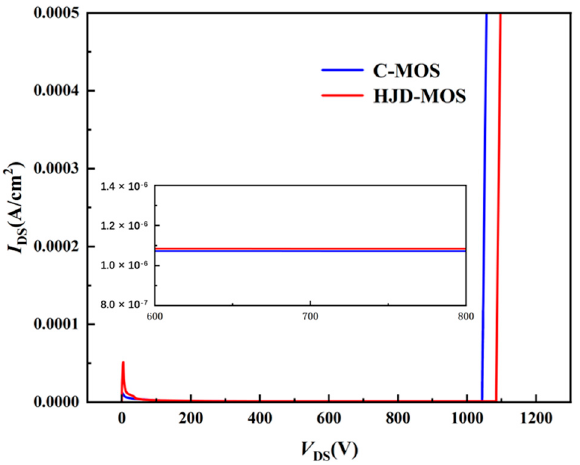
Figure 8. The off-state characteristics of the C-MOS and the proposed structure.